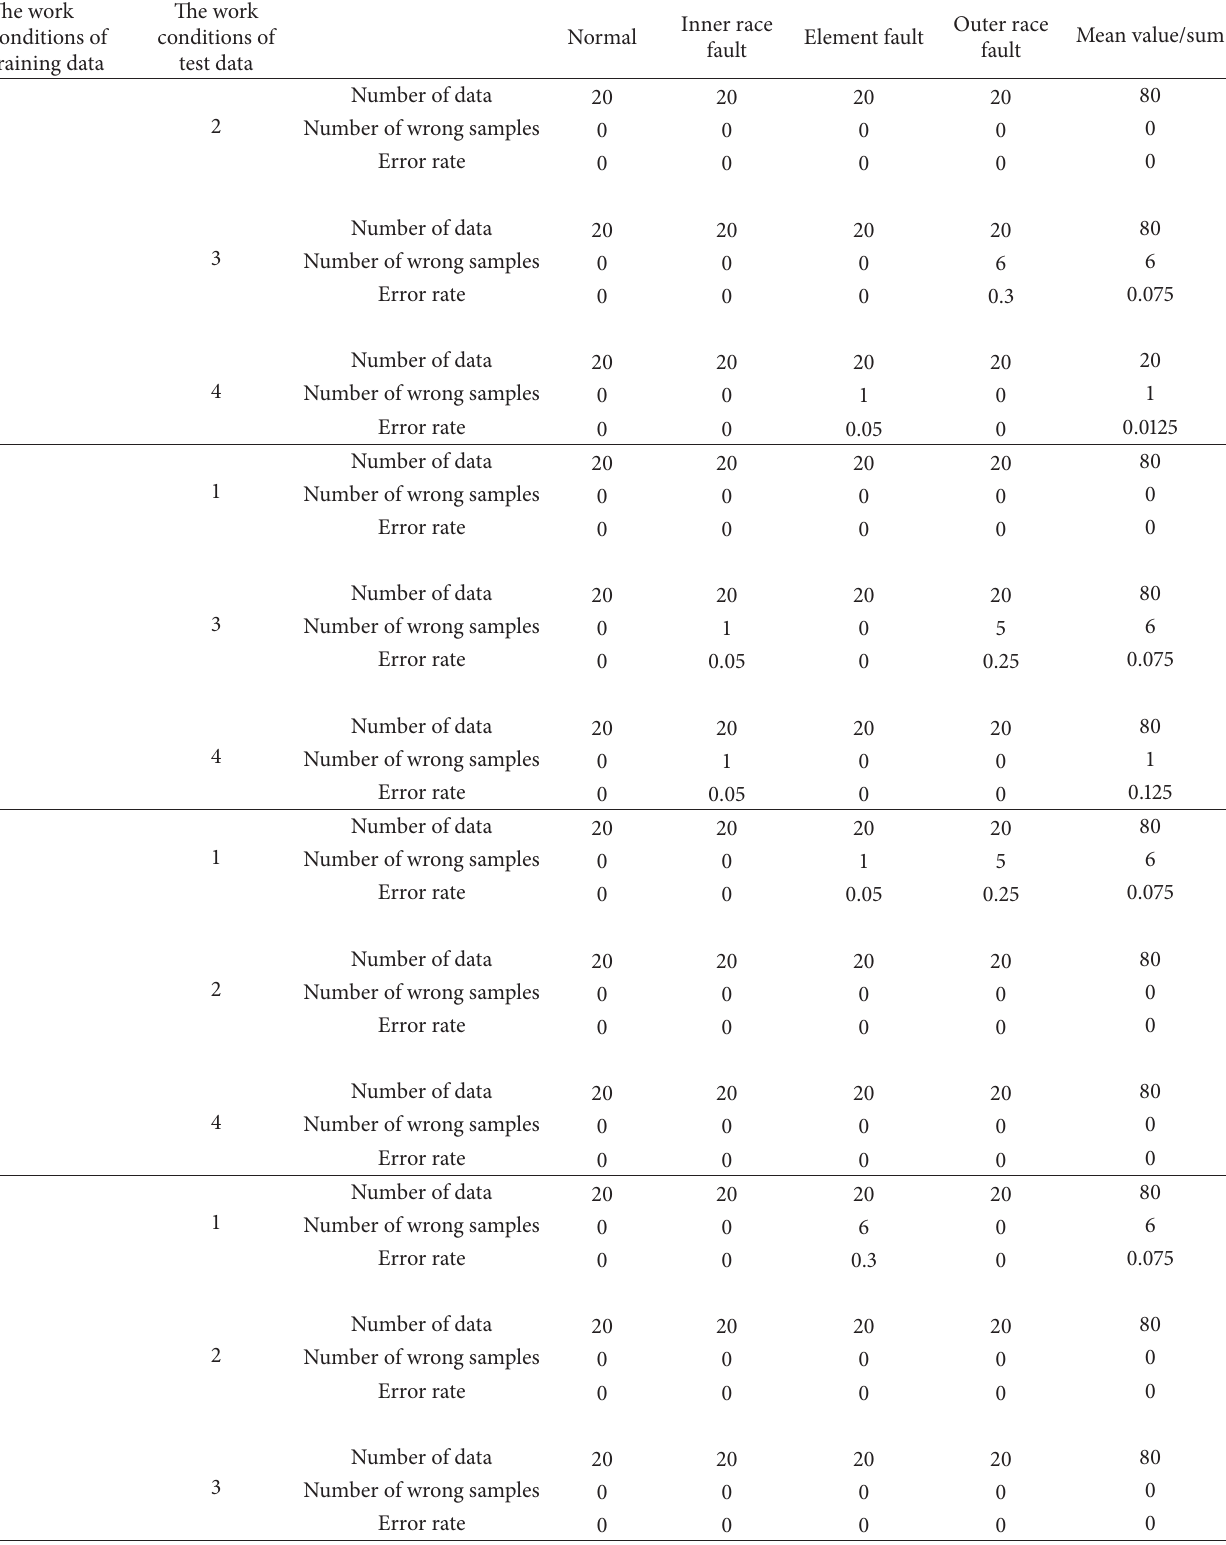
Table 4: The detailed error samples statistics of